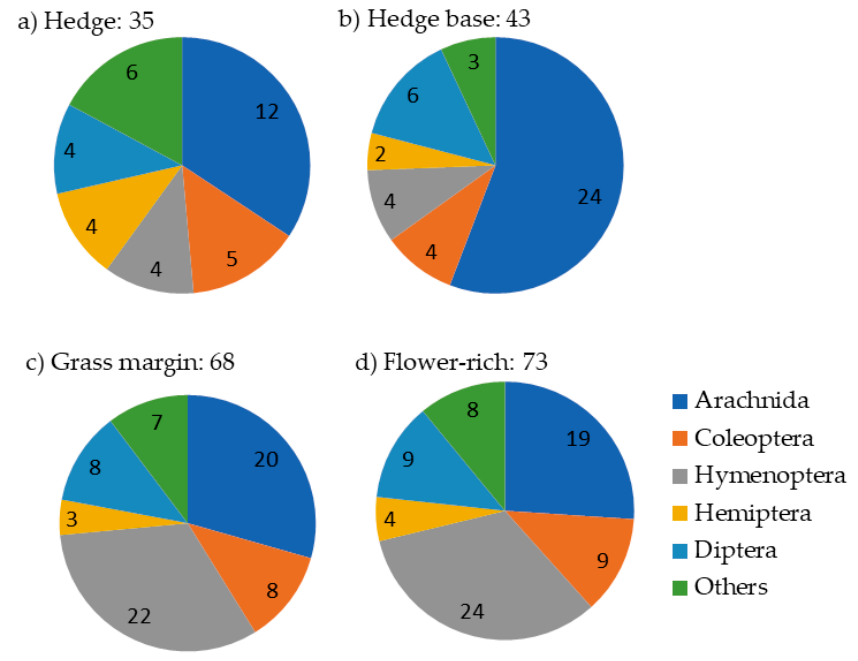
Figure 1. Number of natural enemy families for the predominant taxa in each habitat from a literature survey and eight databases from European projects: Buzz, Development of perennial brood rearing habitats, Farm4Bio, Farm Scale Evaluations of genetically modified herbicide tolerant crops, PEBIL (Potential for Enhancing Biodiversity on Intensive Livestock farms) (UK); Buffer zones for biodiversity of plants and arthropods: is there a compromise on width? (Denmark); The arthropods of grassy field margins (off crop) and the consequences for impact assessment of pesticides on terrestrial ecosystems (Germany); Grey partridge study (France), details in Table S1.